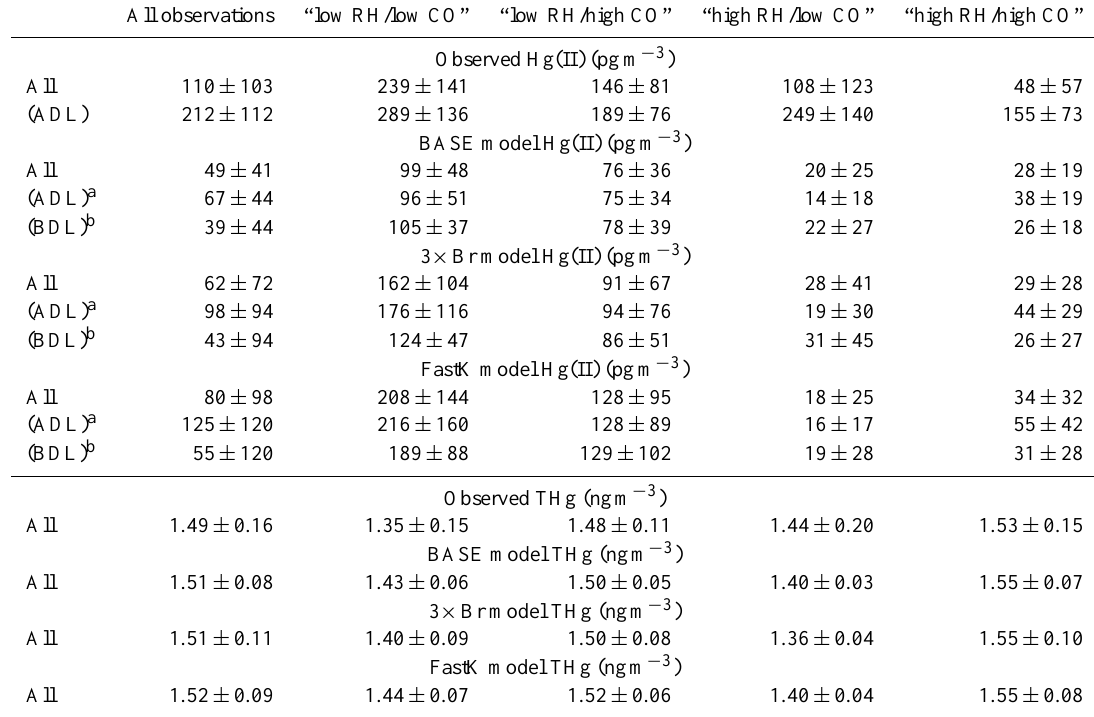
Table 4. Modeled THg and Hg(II) concentrations in the three GEOS-Chem Hg simulations for the four air mass categories. All observations “low RH/low CO” “low RH/high CO” “high RH/low CO” “high RH/high CO” Observed Hg(II) (pgm − 3